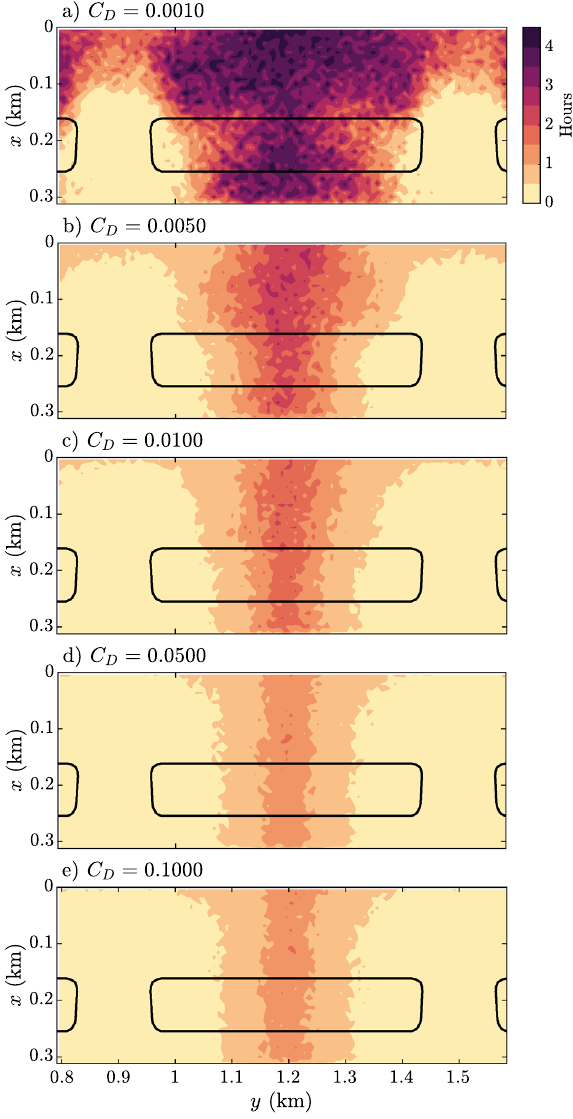
Figure 7. Depth-averaged residence times of particles released an hour before high tide. Solid black lines indicate reef flat